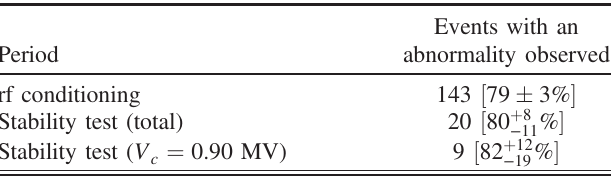
TABLE III. Number of cavity breakdown events with an abnormality observed by at least one of the three TV cameras. Numbers enclosed in square brackets are percentages of the total numbers of cavity breakdown events with binomial errors for a 1 σ confidence